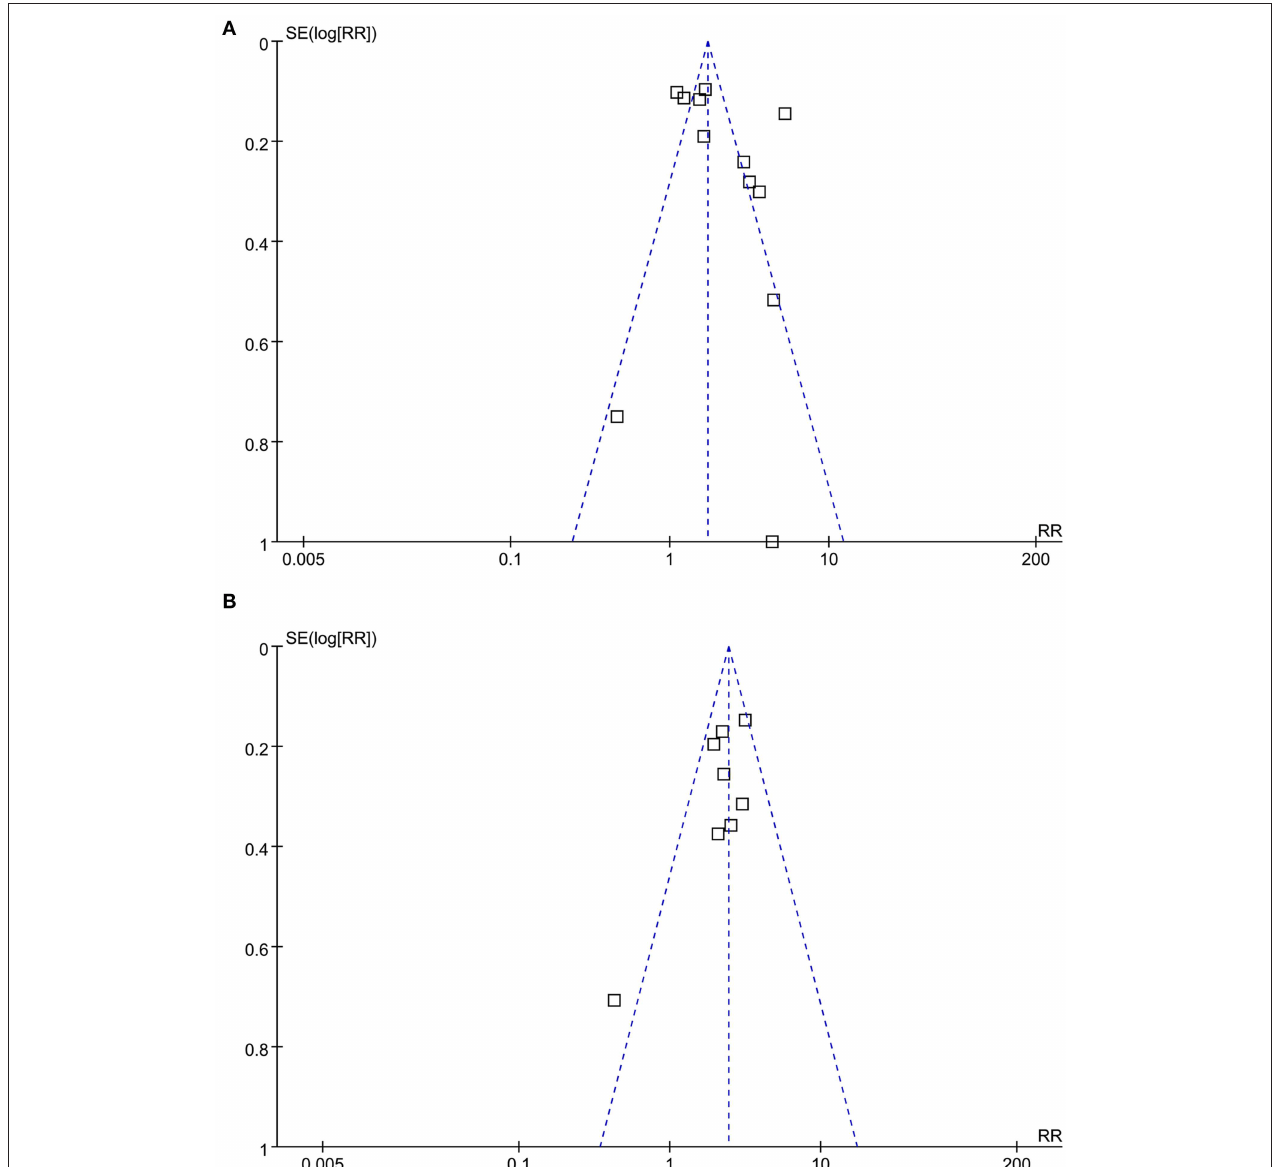
FIGURE 4 | Funnel plots for the publication bias underlying the meta-analysis of the association between the AIP and CAD. (A) Funnel plots for the meta-analysis of the AIP analyzed as a continuous variable; and (B) Funnel plots for the meta-analysis of the AIP analyzed as a categorical